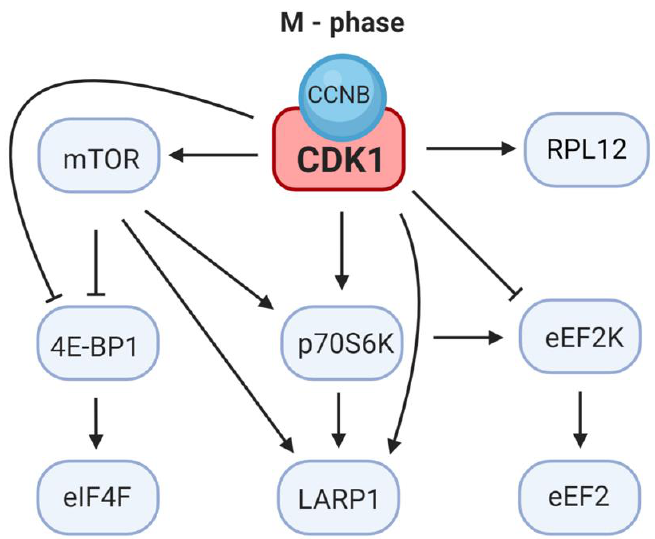
Figure 4. Schematic representation of direct extramitotic effect of cyclin dependent kinase 1 (CDK1) on molecular axis influencing mRNA translation during M-phase. CDK1 activates the mammalian target of rapamycin (mTOR) and subsequently mTOR phosphorylates and activates its substrates ribosomal protein S6 kinase B1 (p70S6K) and LA-related protein 1 (LARP1). Phosphorylation of eukaryotic translation initiation factor 4E (eIF4E)-binding protein 1 (4E-BP1) by mTOR leads to the dissociation of 4E-BP1 from eIF4E and to the activation of the eIF4F complex. CDK1 directly phosphorylates the mTOR substrates 4E-BP1, p70S6K and LARP1. CDK1 exerts inhibitory phosphorylation of the eukaryotic elongation factor 2 kinase (eEF2K) and, as a consequence, the activity of elongation factor 2 (eEF2) is stimulated. The activity of ribosomal protein L12 (RPL12) is also CDK1-dependent.